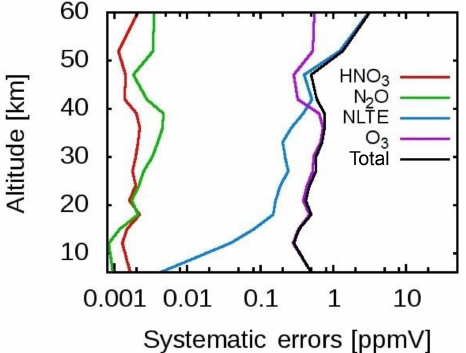
Figure 8. Error components and total systematic error associated with the set of 15MWs that were used in retrieval tests. Only the three atmospheric gases that represent the main sources of error are reported. NLTE indicates the error propagated by neglecting non- local thermal equilibrium conditions in the retrieval